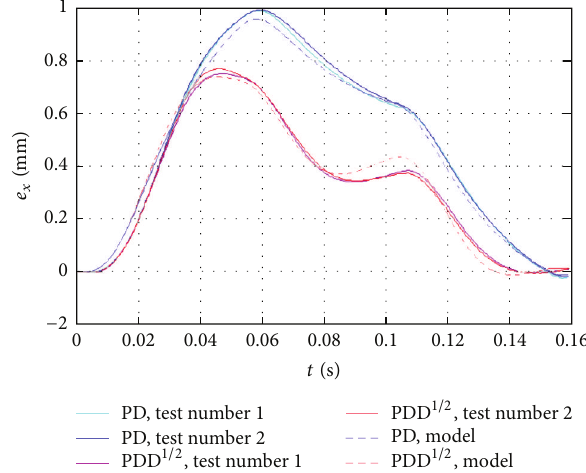
Figure 14: PD-PDD 1/2 comparison: tracking error in case of set point with trapezoidal speed law (PD: 𝜁 = 1 ; PDD 1/2 : 𝜁 = 0.45, and 𝜓 = 1.4266 ).